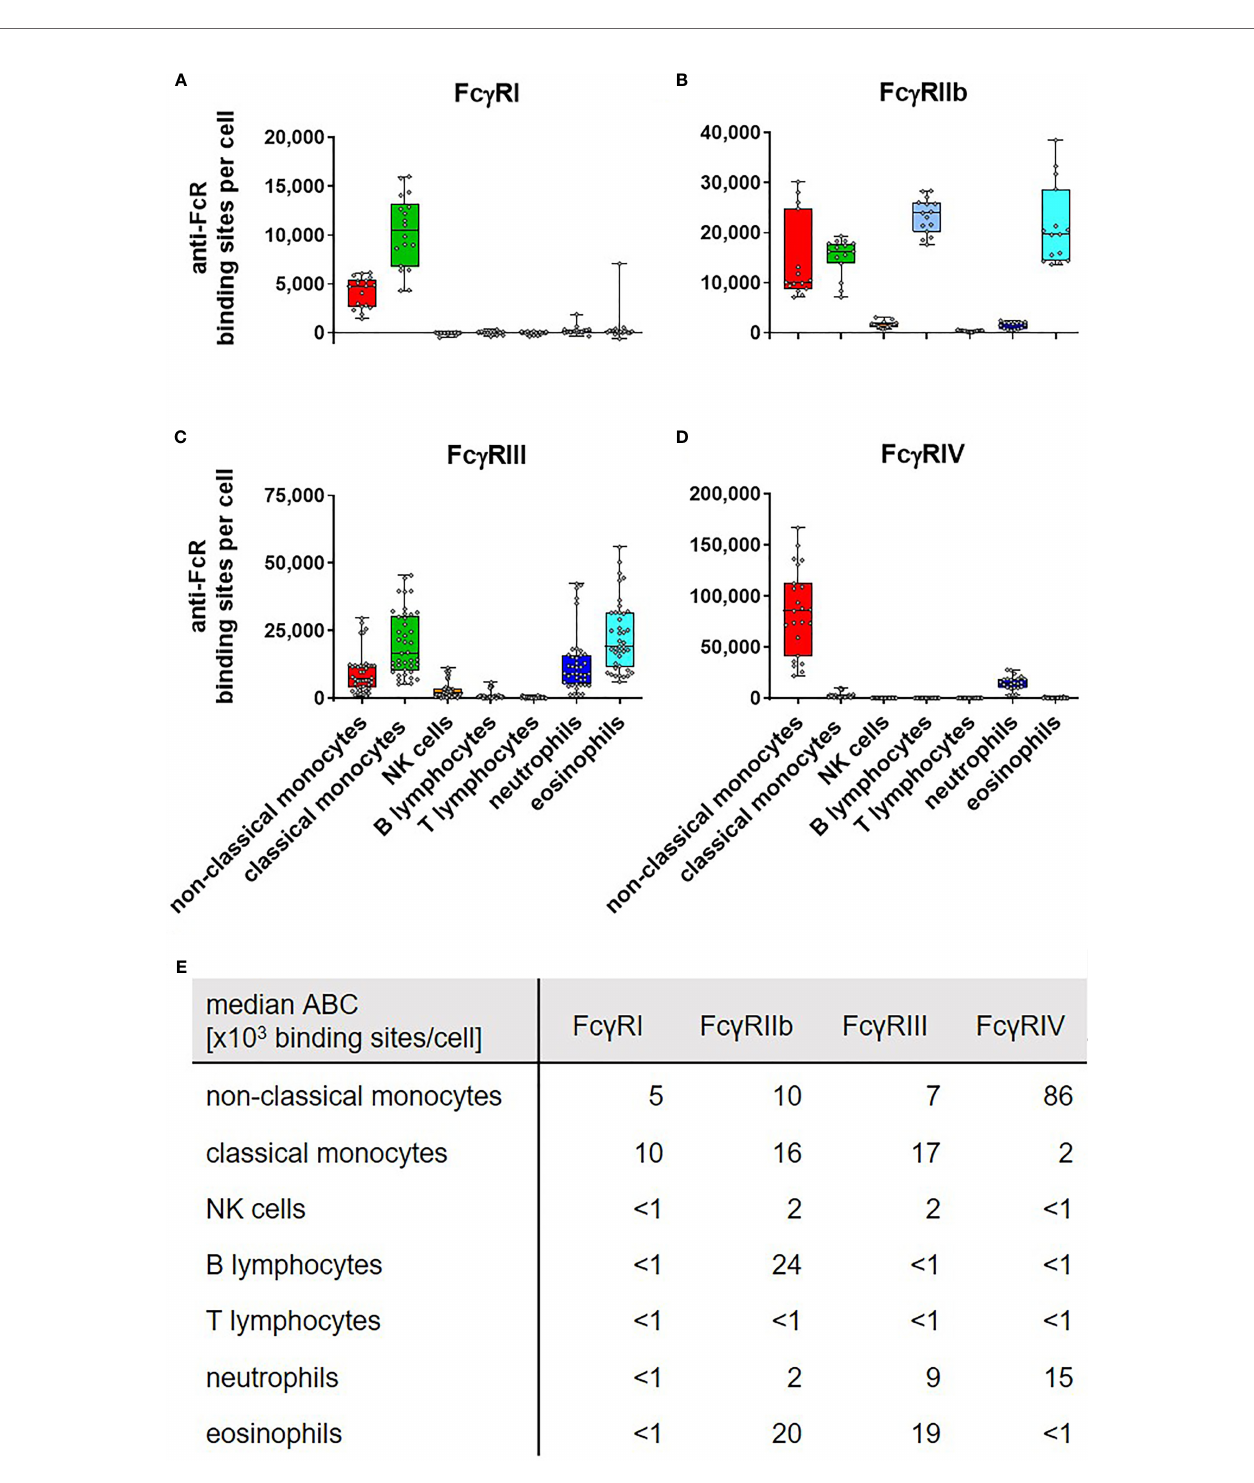
FIGURE 1 | Fc gamma receptors on murine peripheral blood leukocytes. Depicted are box plots showing anti-FcR binding sites for (A) Fc g RI, (B) Fc g RIIb, (C) Fc g RIII, and (D) Fc g RIV on indicated leukocyte subsets together with (E) a tabular presentation of the median number of binding sites. n = 15 – 41 from 4 to 11 independent